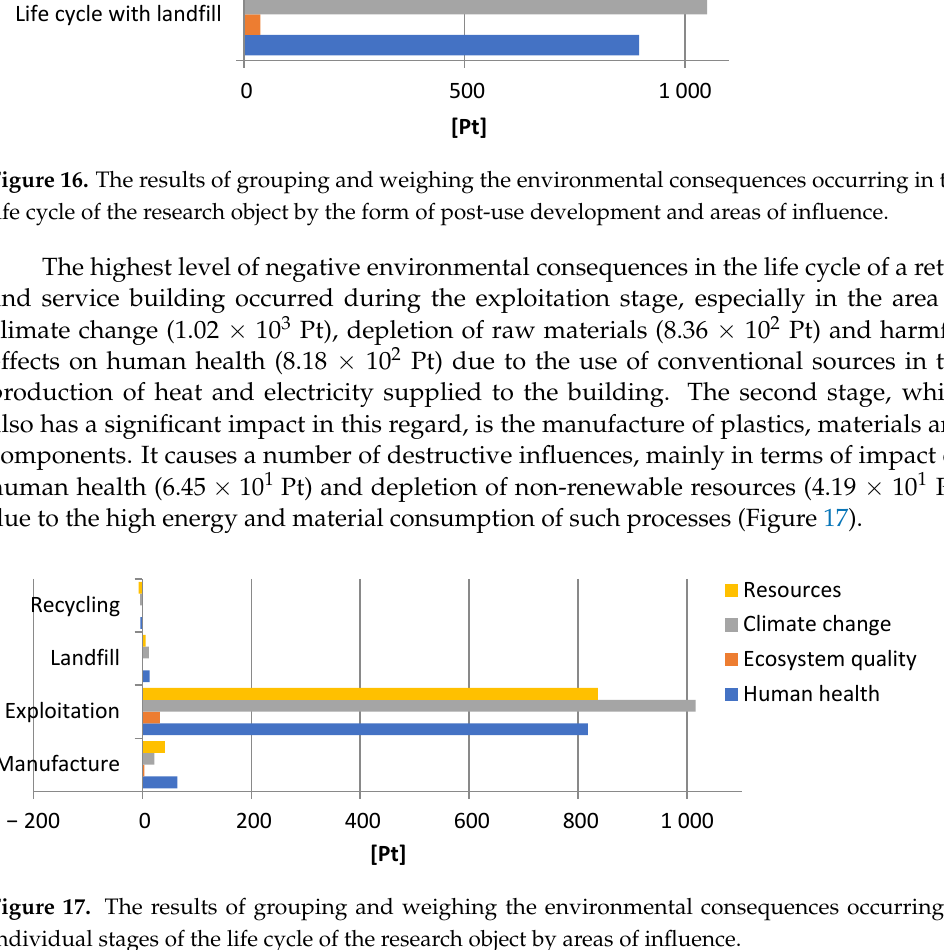
Figure 18. The results of grouping and weighing the environmental consequences occurring at individual stages of the life cycle of the research object by areas of influence. Due to the fact that the area of impact related to climate change causes the most negative environmental consequences in the life cycle of a retail and service building, it was decided to discuss the related emissions in more detail. The Earth’s climate is primarily influenced by the temperature of the air, water, soil surface, rainfall and solar radiation. The natural greenhouse effect is caused by water vapor, carbon dioxide, tropospheric ozone, nitrous oxide, methane, aerosols and cloud particles, all present in the atmosphere in small amounts as well as other trace gases. The key contribution to the increase in the greenhouse effect is CO 2 , of which the greatest anthropogenic sources are the combustion of fossil fuels and deforestation. CH 4 emissions